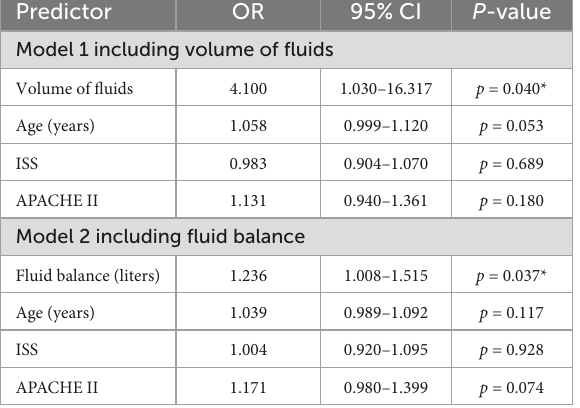
TABLE 2 Multivariable logistic regression analysis of risk factors associated with mortality in critically ill trauma patients. Predictor